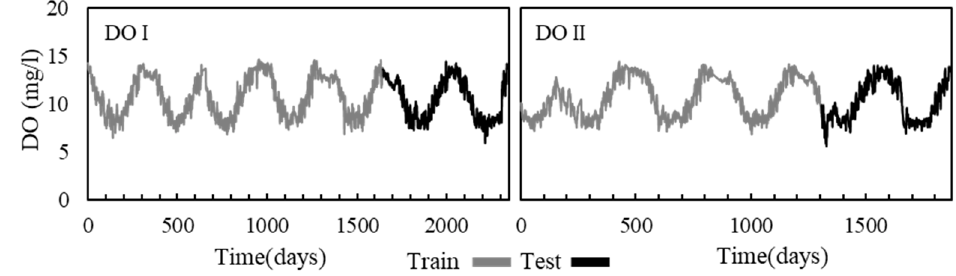
Figure 3. The plot of water quality dissolved oxygen (DO) index data for both stations.